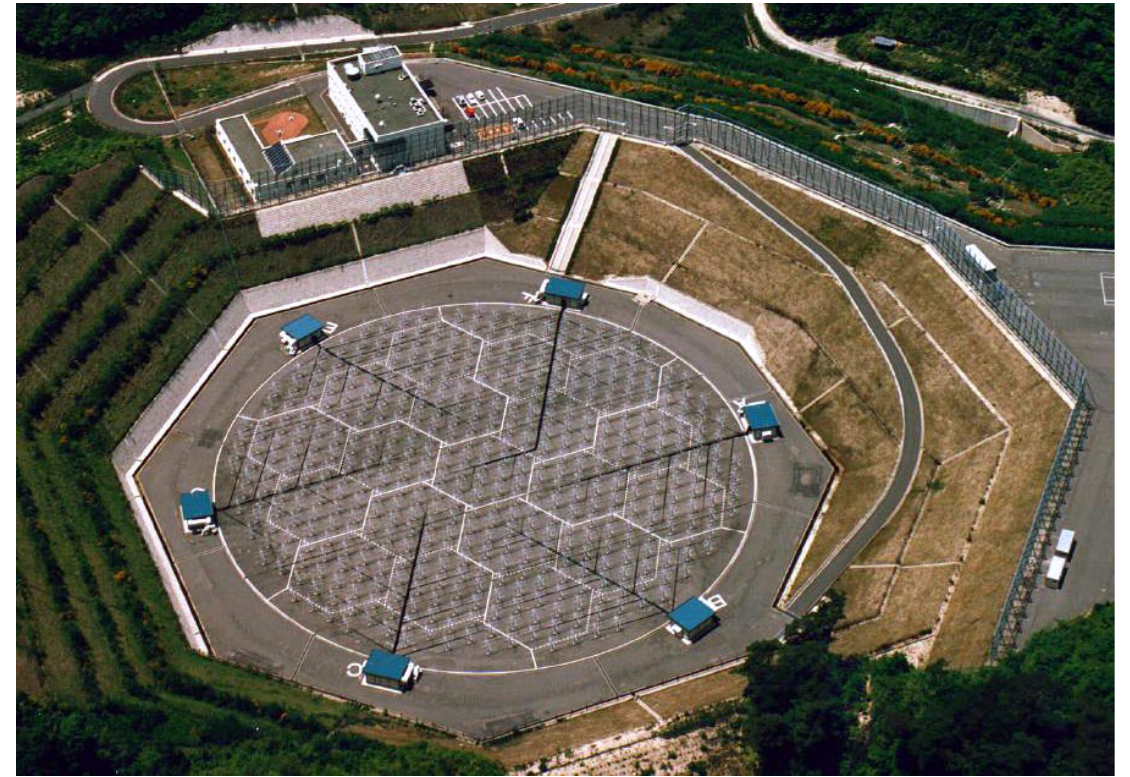
Fig. 1. Aerial photograph of the MU radar, near Shigaraki in the Kinki Region of Japan, soon after its construction in 1981–1983 with guest house and control room at top left.